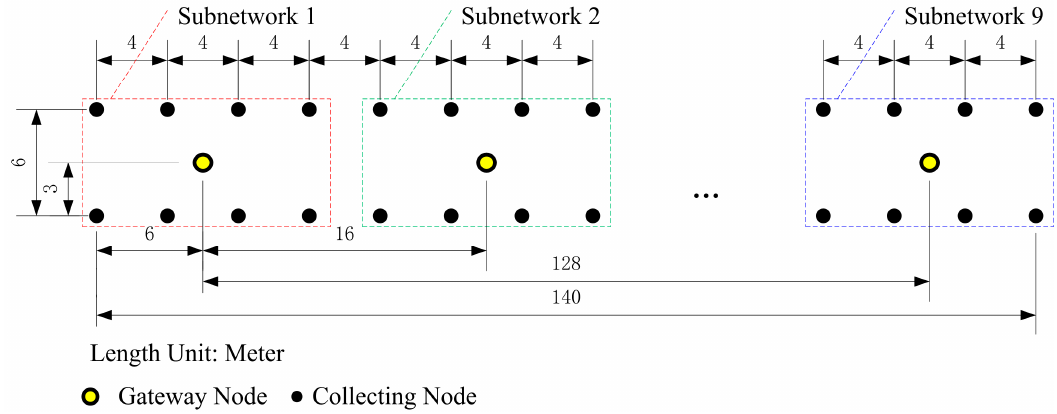
Figure 7. Arrangement of the sensor array.